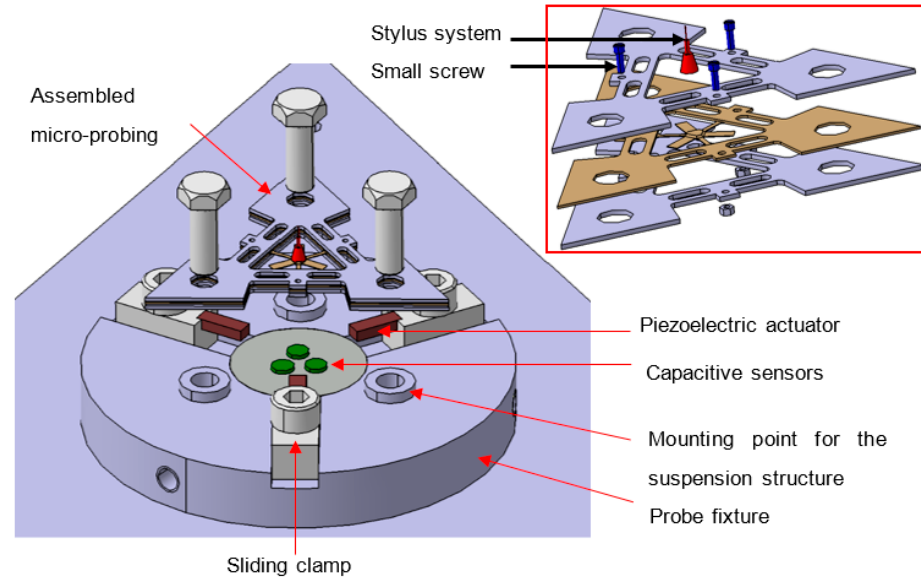
Figure 1. Schema of the assembly of the variable stiffness micro-probing system, with exploded view inset.